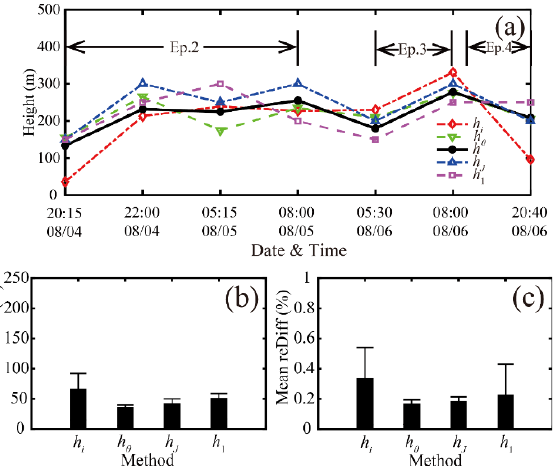
Figure 12. ( a ) Comparison among the four observation-derived SBL heights ℎ 𝑖 , ℎ 𝜃 , ℎ 𝐽 , and ℎ 1 (dashed lines) with the calculated SBL height ℎ (solid line) during three episodes: Ep. 2, Ep. 3, and Ep. 4. ( b ) Mean absolute difference (Mean absDiff) and ( c ) mean relative difference (Mean reDiff) values and corresponding one standard deviation (shown by error bars) obtained by using each method shown in Figure 8, 10, and Figure S6 during the three episodes of Ep. 2, Ep. 3, and Ep. 4. In addition, it should be noted that Figure 12a is not simply a succession of time – height cross section; we simply superposed the episodes for convenience.